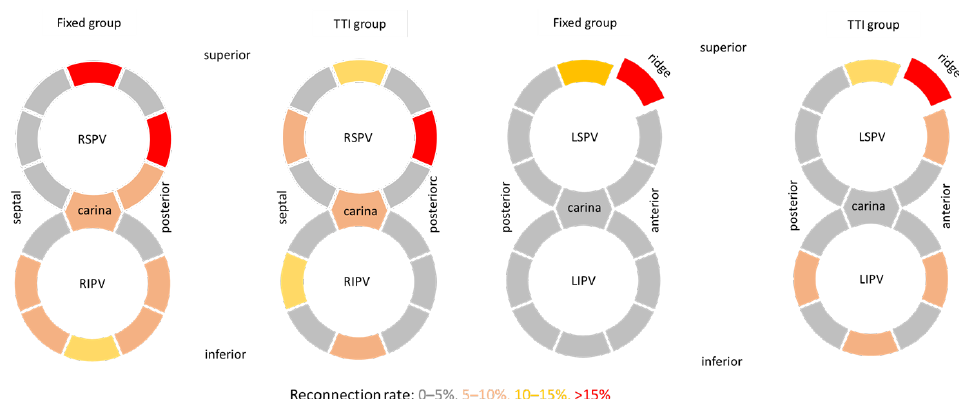
Figure 4. Segmental localization of electrical reconduction gaps at the PV ostium during RF redo procedure. Colors indicate the number of reconnections found in each segment, showing predominant LSPV reconduction gaps at the ridge and RSPV reconduction gaps (anterior and superior).